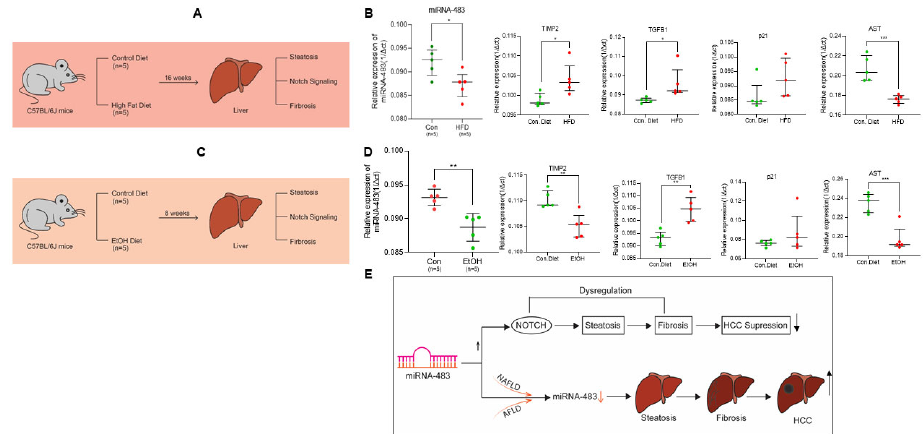
Figure 7. Association of miR ‐ 483 and fibrogenic markers expression in NAFLD and AFLD mouse model. ( A ) The schematic represents the strategy for the development of NAFLD as described in the materials and methods section. ( B ) Male C57BL/6J mice pair ‐ fed with a control diet ( n = 5) or HFD ( n = 5) for 16 weeks, total RNAs from liver tissues were also isolated, and the expression of miR ‐ 483 and fibrosis signaling gene expression markers were analyzed by RT/qPCR (Green circles represent the control mice liver samples, and the red circles represent the HFD ‐ fed mice liver sam ‐ ples). * p < 0.05, *** p < 0.001 compared with control diet ‐ fed mice. ( C ) The schematic represents the strategy for the development of the AFLD mouse model. ( D ) Male C57BL/6J mice pair ‐ fed with a control diet ( n = 5) or EtOH diet ( n = 5) for 8 weeks, total RNAs from liver tissues were isolated, and the expression of miR ‐ 483 and fibrosis signaling gene expression markers were analyzed by RT/qPCR (Green circles represent the control mice liver samples, and the red circles represent the EtoH ‐ fed mice liver samples). ** p < 0.01, *** p < 0.001 compared with control diet ‐ fed mice. ( E ) A schematic model represents the role of miR ‐ 483 in the inhibition of HCC cell proliferation and its association with NAFLD and AFLD progression. Similarly, we also analyzed the expression of miR ‐ 483, fibrosis markers, and Notch(s) receptors in an AFLD mice model (Figure 7C). Mice fed an EtOH ‐ containing diet showed hepatic steatosis and not in mice liver fed with the control diet [42]. Similar to the NAFLD mice model, expression of miR ‐ 483 was also downregulated in mice liver fed with EtOH containing diet ( p < 0.01) compared with control diet ‐ fed animals (Figure 7D, left panel). Fibrogenic TGF β expression was significantly increased ( p < 0.01) in these samples. How ‐ ever, the expression of TIMP2 and AST1 was downregulated. No significant change in the expression of p21 , Notch1 , Notch2, and Notch4 was observed in these samples (Figure 7D, right panels, and Supplementary Figure S2B). Increased expression of Notch3 was de ‐ tected in mice liver fed with EtOH containing diet (Figure 7D, right panels, and Supple ‐ mentary Figure S2B). Considering these results, our data suggest that miR ‐ 483 expression is downregulated in both NAFLD and AFLD mice models that could be involved in the modulation of the fibrogenic signaling in mice liver. 4. Discussion Hepatocellular carcinoma (HCC) carries a significant threat of cancer ‐ related mortal ‐ ity [1]; thus, identifying biomarkers in the early stages of NAFLD, AFLD, and subsequent HCC progression is crucial. Due to their stability in various bodily fluids, miRNAs are currently studied as prognostic and diagnostic markers for various diseases, including